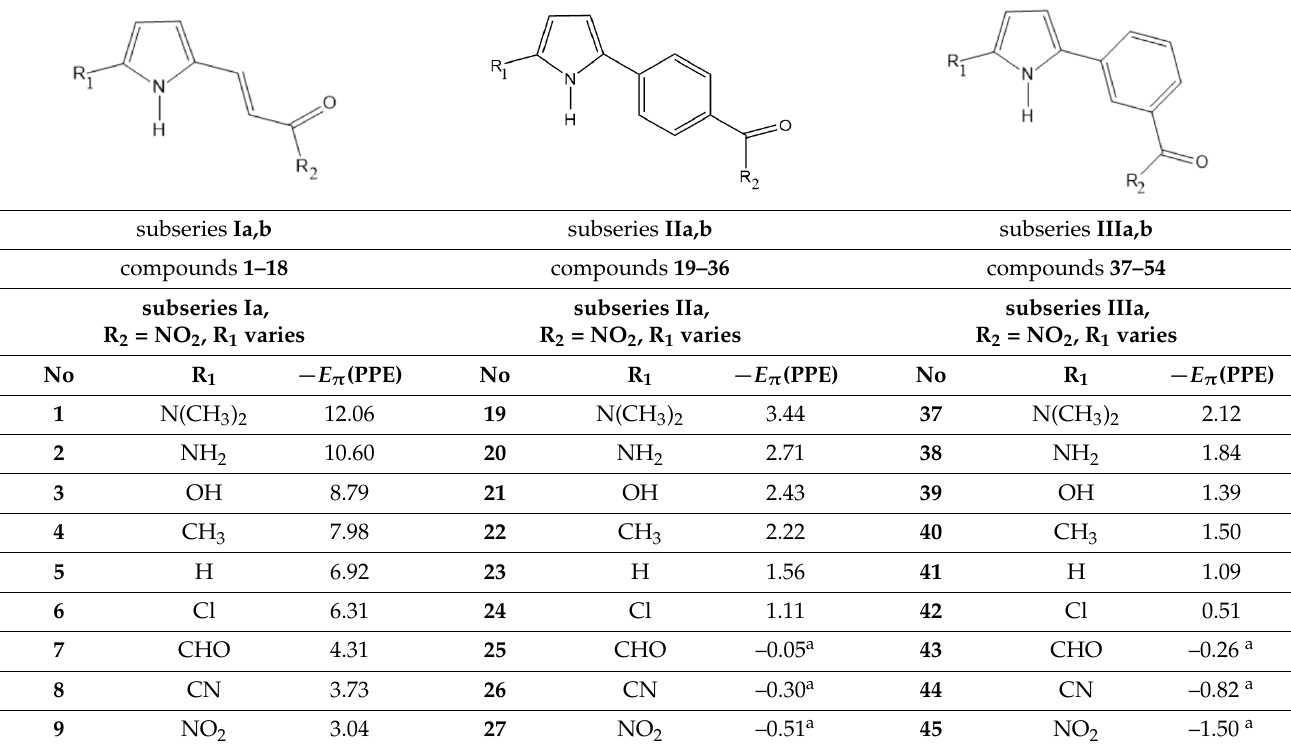
Table 1. Studied subseries Ia,b – IIIa,b of compounds 1–54 and − E π (PPE) values for them (in kcal/mol).